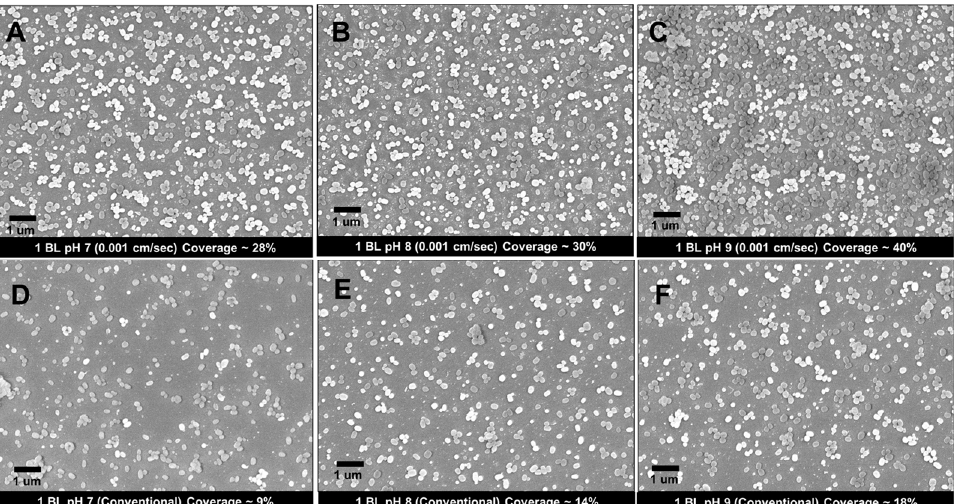
Figure 3. Top-view SEM images of 1-BL coatings deposited at different pH and dipping conditions. The coverage was estimated by ImageJ analysis of 10 images: ( A ): 1-BL coating at pH 7 (controlled dipping at speed 0.001 cm/s); ( B ): 1-BL coating at pH 8 (controlled dipping at speed 0.001 cm/s); ( C ): 1-BL coating at pH 9 (controlled dipping at speed 0.001 cm/s); ( D ): 1-BL coating at pH 7 (conventional dipping); ( E ): 1-BL coating at pH 8 (conventional dipping); ( F ): 1-BL coating at pH 9 (conventional dipping).